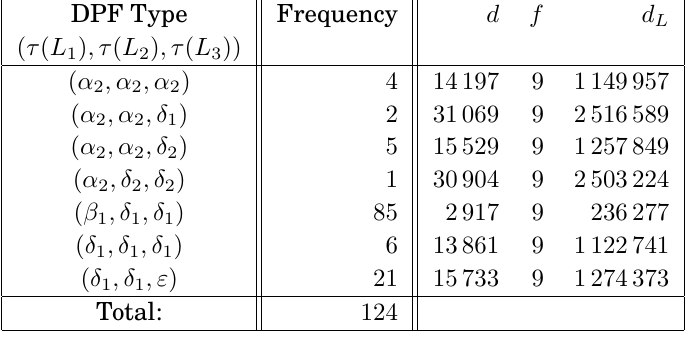
Table 24: Types of triplets with critical split prime power conductor f = 9